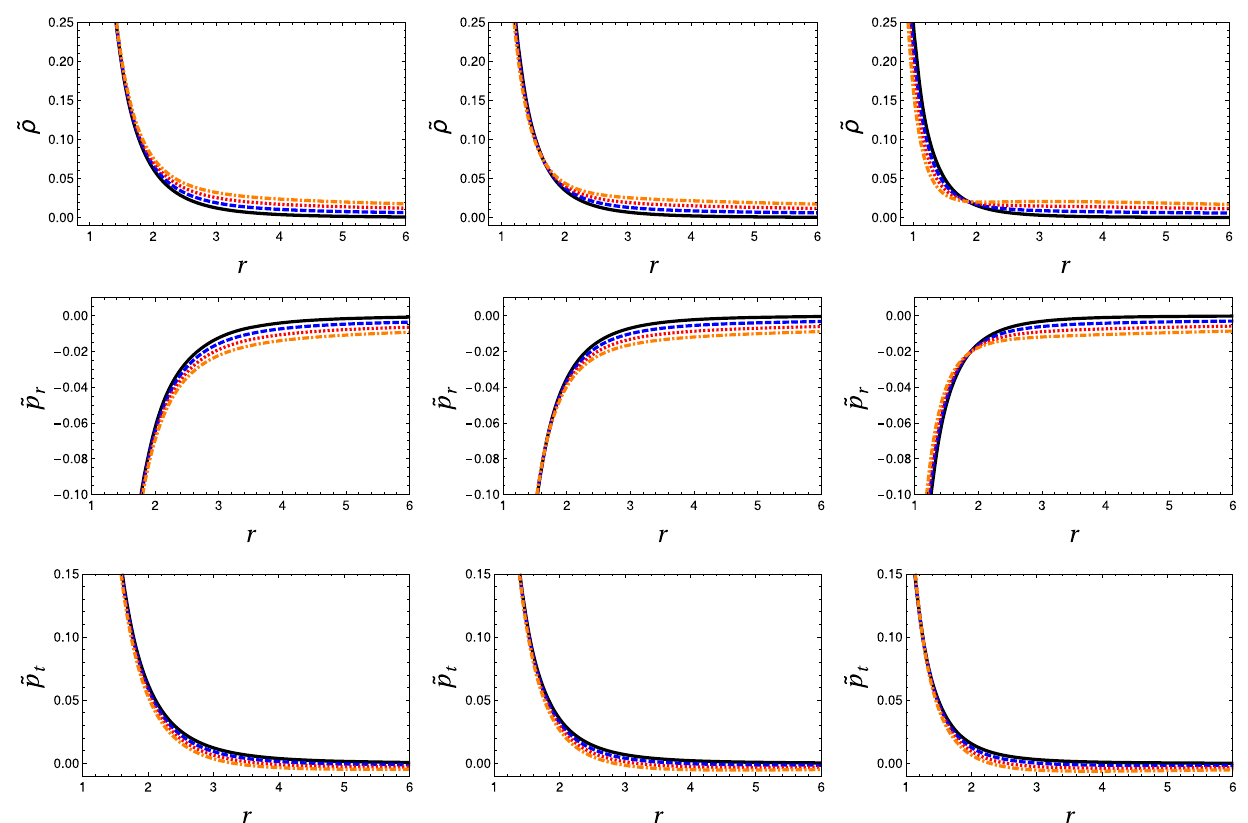
line), (ii) α = − 0 . 025 (dashed blue line), (iii) α = − 0 . 050 (dotted red line) and finally (iv) α = − 0 . 075 (dot-dashed orange line). The first, second and third column correspond to Q = 1, Q = 0 . 75 and Q = 0 . 5 respectively. The rest of the parameters are taken to be